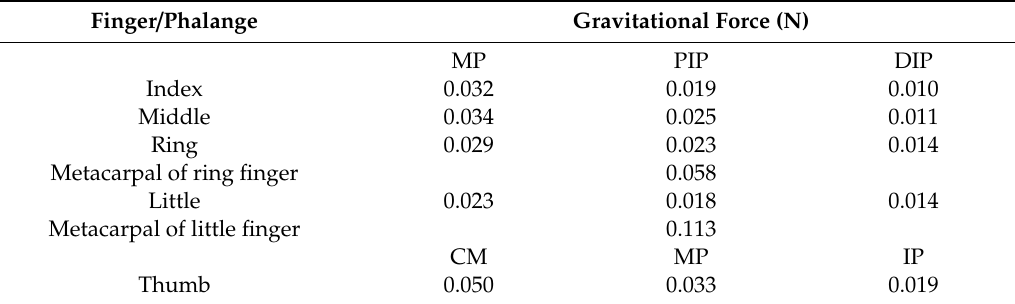
Table A2. Gravity force of each